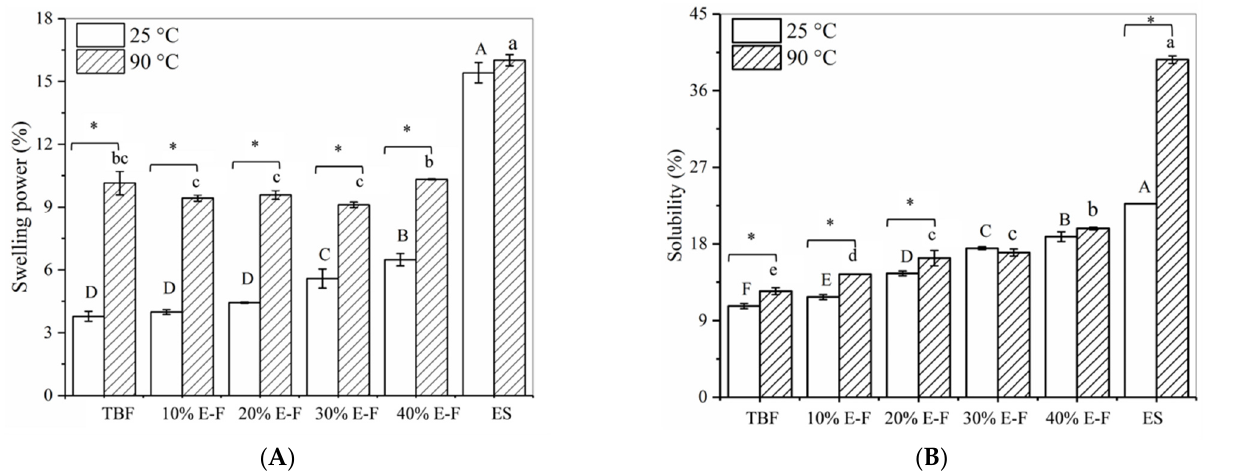
Figure 1. The swelling power ( A ) and the solubility ( B ) of TBF, ES, and blended flour at 25 and 90 °C. ES and TBF represent extruded Tartary buckwheat starch and Tartary buckwheat flour, respectively. The 10% E-F, 20% E-F, 30% E-F, and 40% E-F represent that the addition of extruded starch in the blended flour was 10%, 20%, 30%, and 40%, respectively. Different letters in the same column represent significant differences ( p < 0.05). * Represents the significant difference between two adjacent groups ( p <